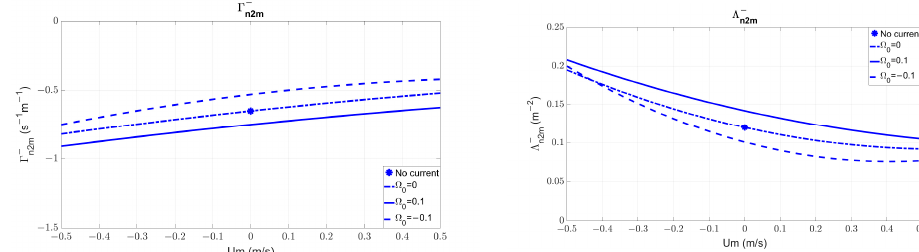
Figure 12. Γ (stream function coefficient) and Λ (surface elevation coefficient) of the n2m-negative Figure 12. 𝛤 (stream function coefficient) and 𝛬 (surface elevation coefficient) of the n2m-negative interaction component as functions of current velocity at the mid-depth. interaction component as functions of current velocity at the mid-depth.